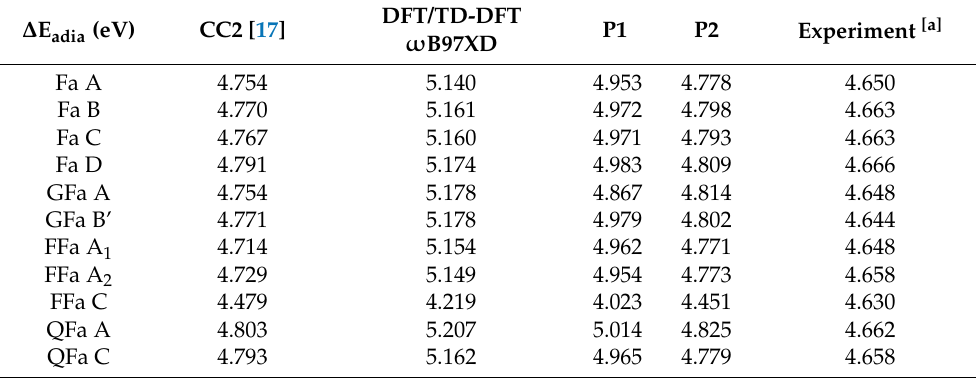
Table 7. Adiabatic ZPVE-corrected excitation energies of the lowest ππ * excited state (S 1 ) of the Fa A-D, GFa A and B’, FFa A 1 , A 2 , and C and QFa A and C conformers obtained with the protocols P1 and P2, together with the CC2/aug-(N,O, π )-cc-pVDZ//CC2/cc-pVDZ ones and the experimental 0–0 transition